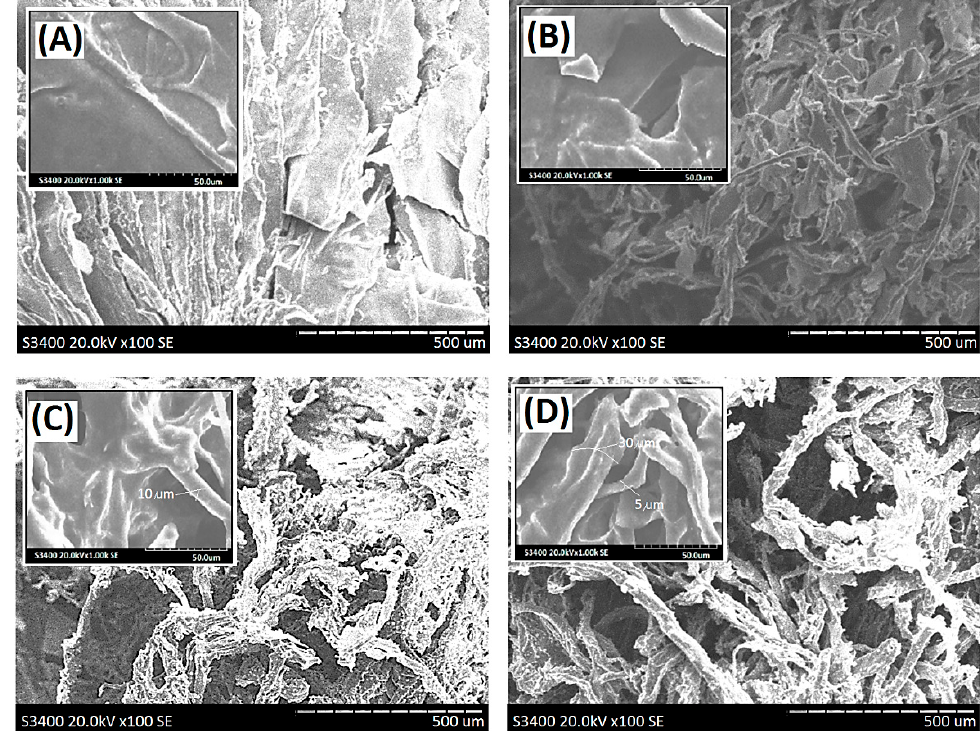
Figure 4. Scanning electron micrographs of the ALG/dECM composite scaffold membrane samples ( A ) AdE1H, ( B ) AdE2H, ( C ) AdE3H, and ( D ) AdE4H.